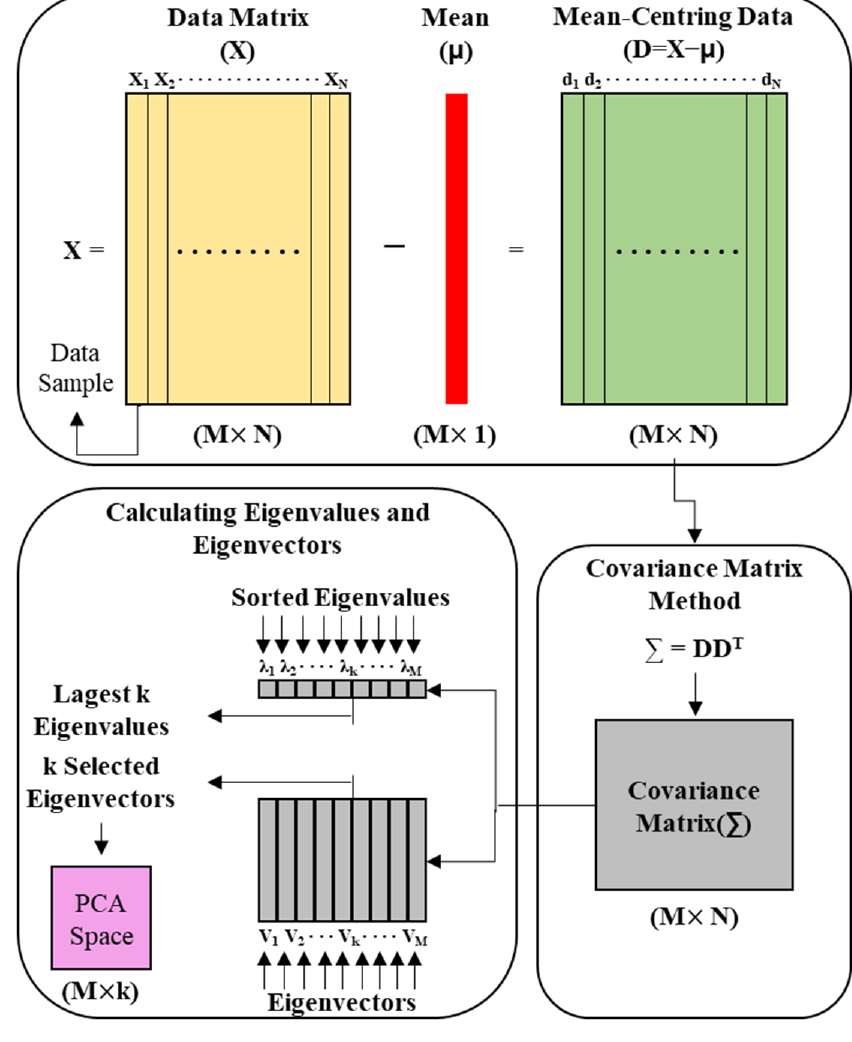
Figure 6. Procedure of PCA.